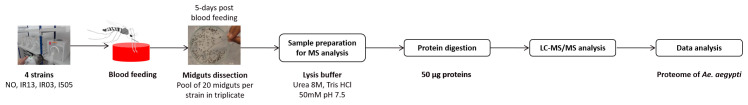
Mains steps of the proteomic experiment.